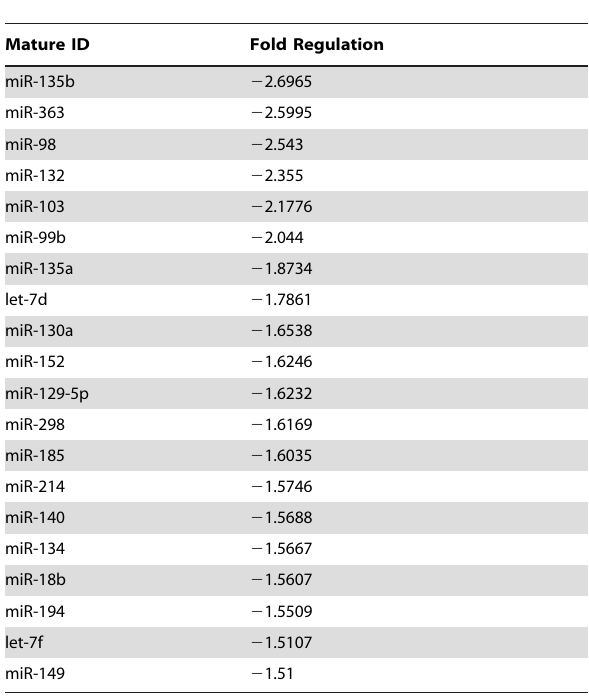
Table 2. List of miRNAs strongly affected by the mutation in Dicer d/d